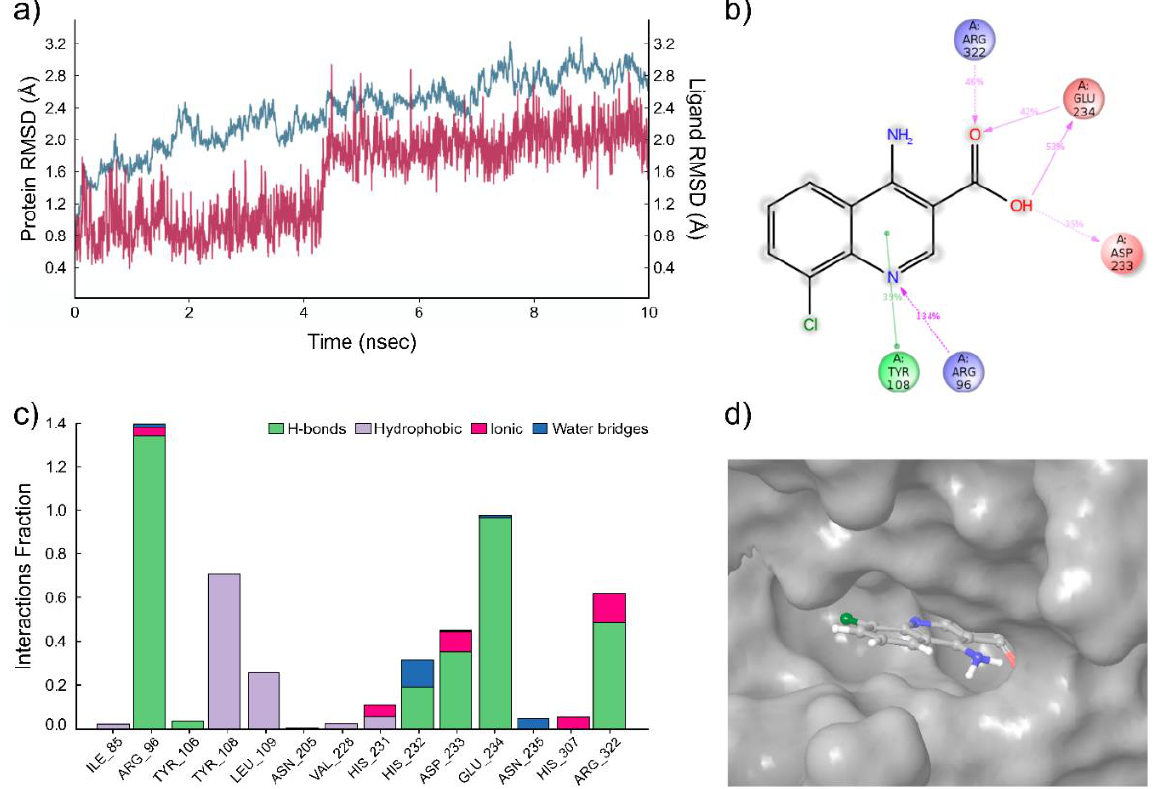
Figure 3. Results of the molecular dynamics simulation of the FTO complex with compound 2 . ( a ) The protein and ligand position root mean square deviation (RMSD) plot against time in the case of the FTO complex with compound 2 for a representative 10 ns run. ( b ) Desmond 2D profile data for the compound 2 binding to FTO protein. ( c ) Normalized stacked bar chart representation of interactions and contacts over the course of trajectory (values over 1.0 are possible as some residues make multiple contacts of same subtype with ligands); interactions occurring more than 50% of the simulation time. Interaction diagram between the compound 2 and FTO protein. ( d ) The position of the compound 2 in the structure of FTO, related to Figure 1a.